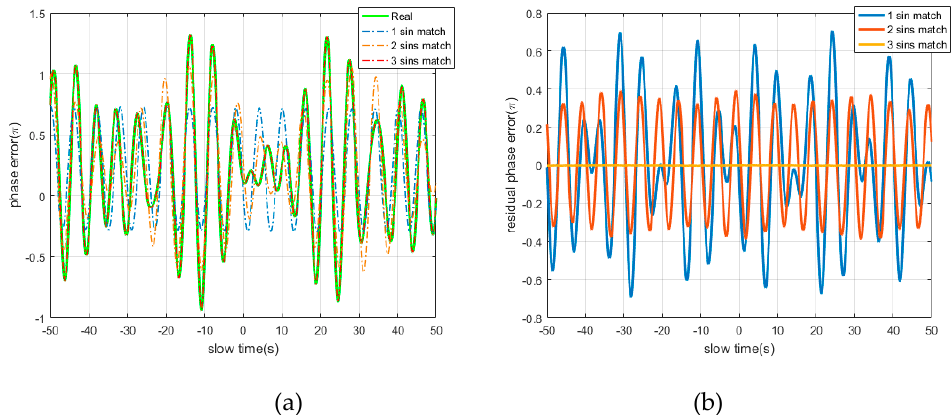
Figure A1. The matched results of rotational motion with the sum of sinusoidal functions 1–3 within 100 s of the CPI: (a) the phase error caused by the rotation effect and the matched results; (b) the residual phase error after matching.